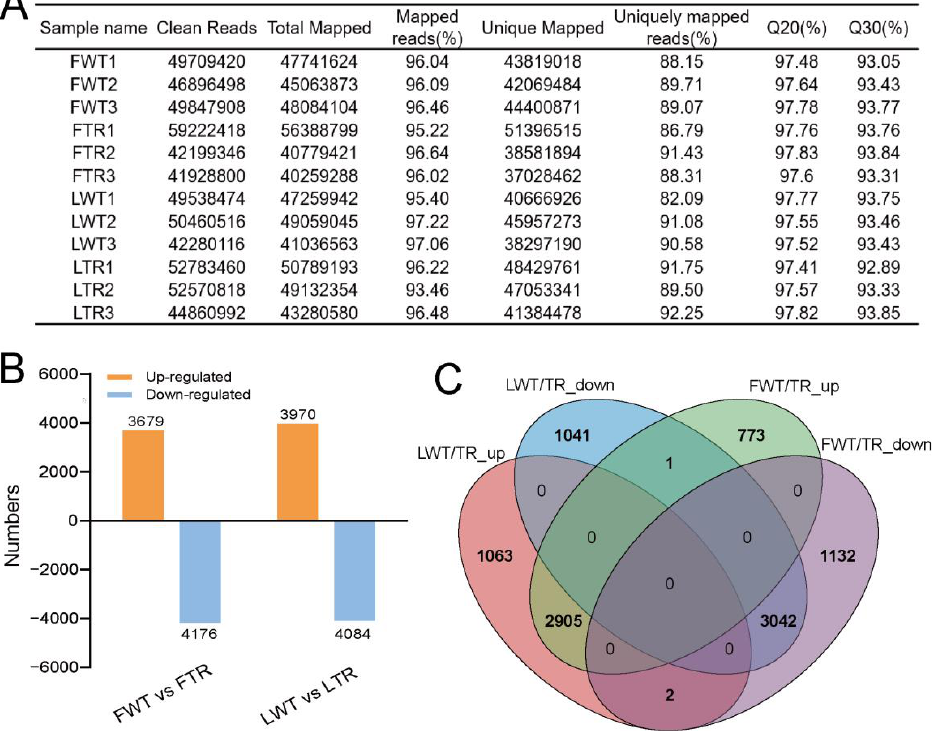
Figure 4. Statistical summary of flax transcriptomes. ( A ) Digest of data generated in flax transcrip- tome sequencing. ( B ) The number of upregulated (orange) and downregulated (blue) DEGs between each comparison. ( C ) Venn diagram showing the number of shared upregulated and downregulated DEGs among the two varieties. FWT, water treatment Fanni; FTR, NaCl stress-treated Fanni; LWT, water treatment Longya10; LTR, NaCl stress-treated Longya10.